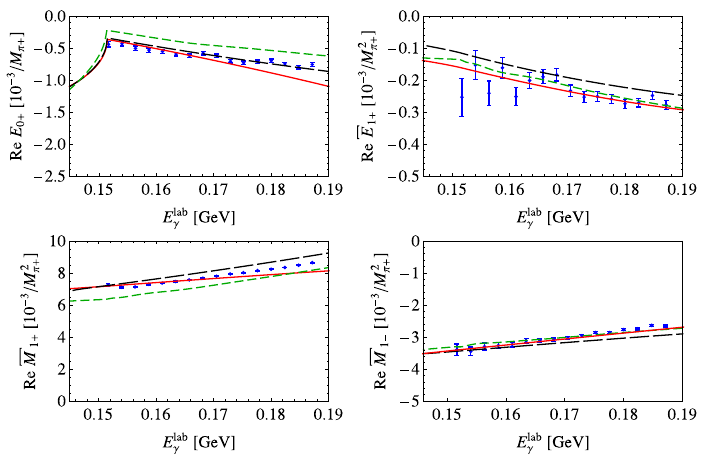
Figure 1. S - and reduced P -wave multipoles for (cid:2) + p → p + (cid:1) 0 . The solid (red) curves show our RChPT calculations at O ( q 4 ). The short-dashed (green) and long-dashed (black) curves are the predictions of the DMT model [4] and the GL model [5], respectively. The data are from Ref.